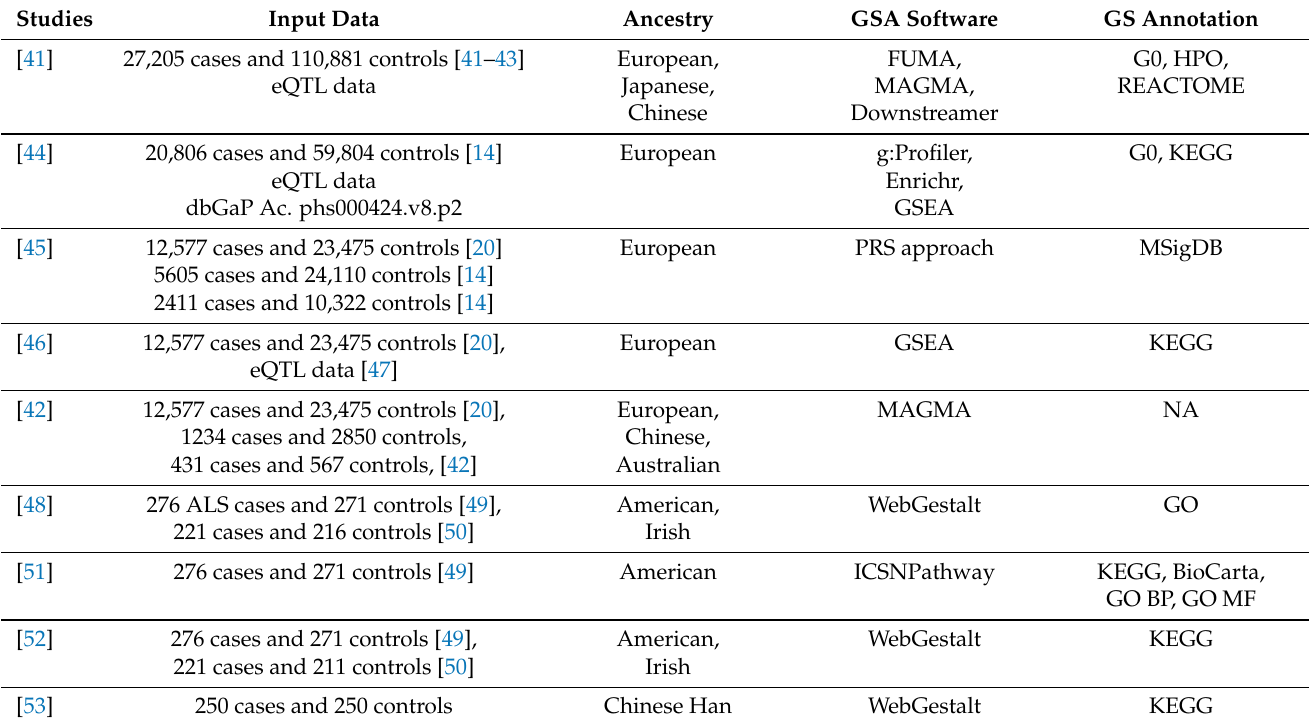
Table 1. Current ALS GWAS studies that employ gene-set analysis (GSA) approaches. The ALS GWAS-GSA studies are described by the cohort size of input data, the ancestry of the genomic cohorts, the GSA software that is used, and, lastly, the source of the collected gene set annotations. The studies are sorted by chronological order of publication. ALS: Amyotrophic Lateral Sclerosis, BP: